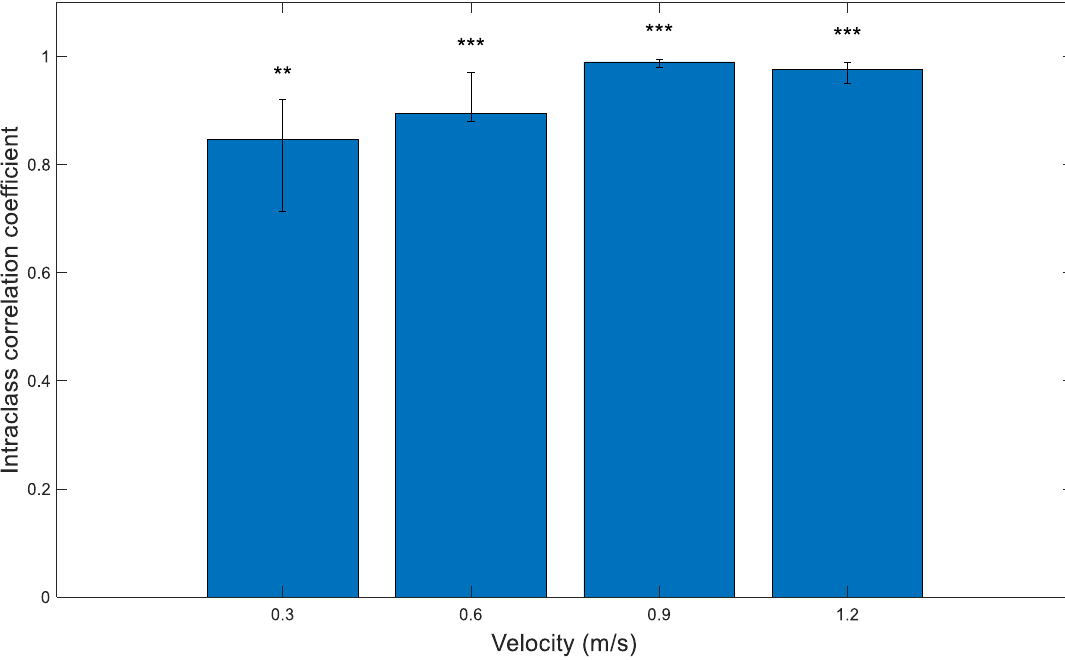
Figure 5. Single measure intraclass correlation coefficients (ICC) between right limb EMG peaks of the medial gastrocnemius detected by mTrigger and DELSYS at different speeds for treadmill walking with 95% confidence interval. All correlations were significant at p < 0.05. Agreement: ** = good, *** = excellent.